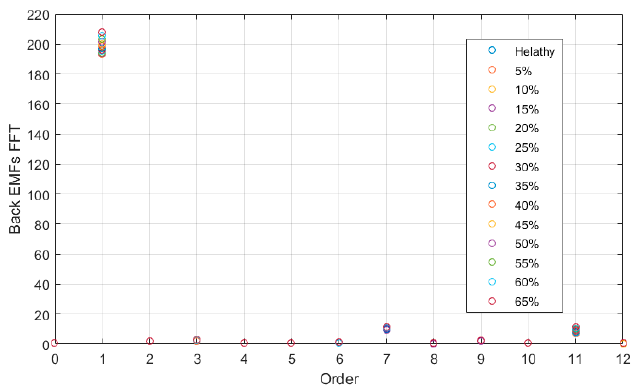
Figure 18. The fast Fourier transform (FFT) of back EMF under SE condition varies from 0% to 65%.